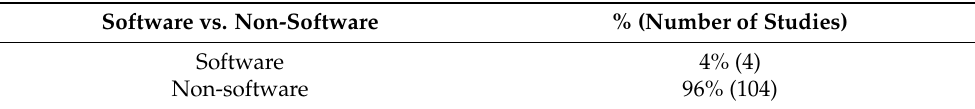
Table 3. Percentage and number of studies GSTFT received in 2019 grouped under software vs.